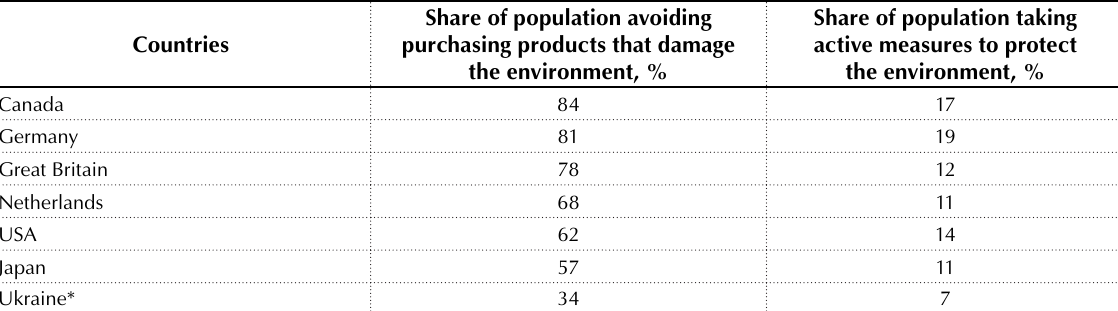
Table 4. The activity of consumers in different countries in relation to environmental goods and environmental initiatives in